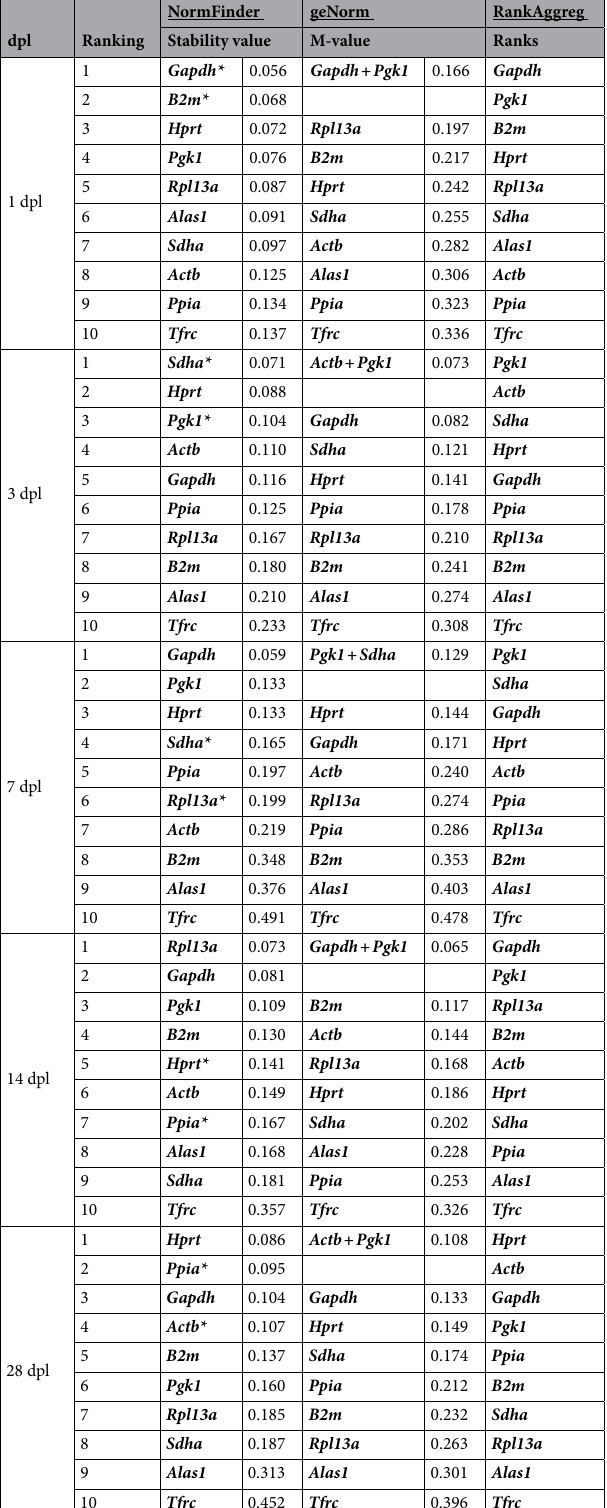
Table 1. Ranking of candidate reference genes according to their expression stability in the dentate granule cell layer following entorhinal denervation. Ranking of candidate reference genes for the granule cell layer at specific time-points (1, 3-, 7-, 14- and 28-days post lesion (dpl)) after entorhinal denervation. Reference genes were ranked according to (1) stability values calculated by NormFinder, (2) averaged expression by geNorm and (3) using a consensus ranking analysis by RankAggreg. Asterisks (left column) indicate the RGs selected as ‘best combination of two RGs’ by